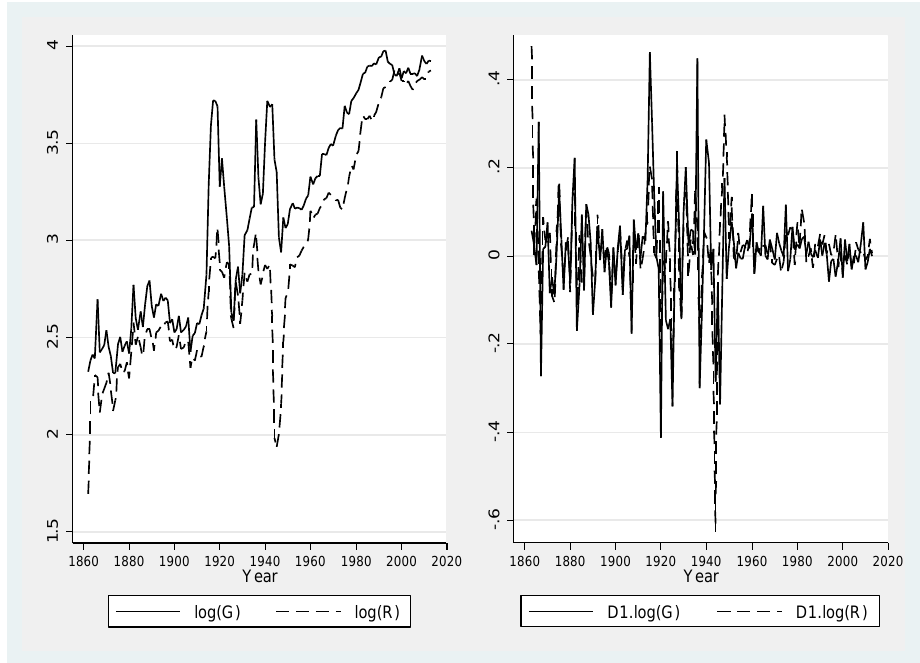
Figure 1 . Public expenditure and revenue in Italy (1862-2013, (% of GDP, log-scal). Source: Forte (2011) and own